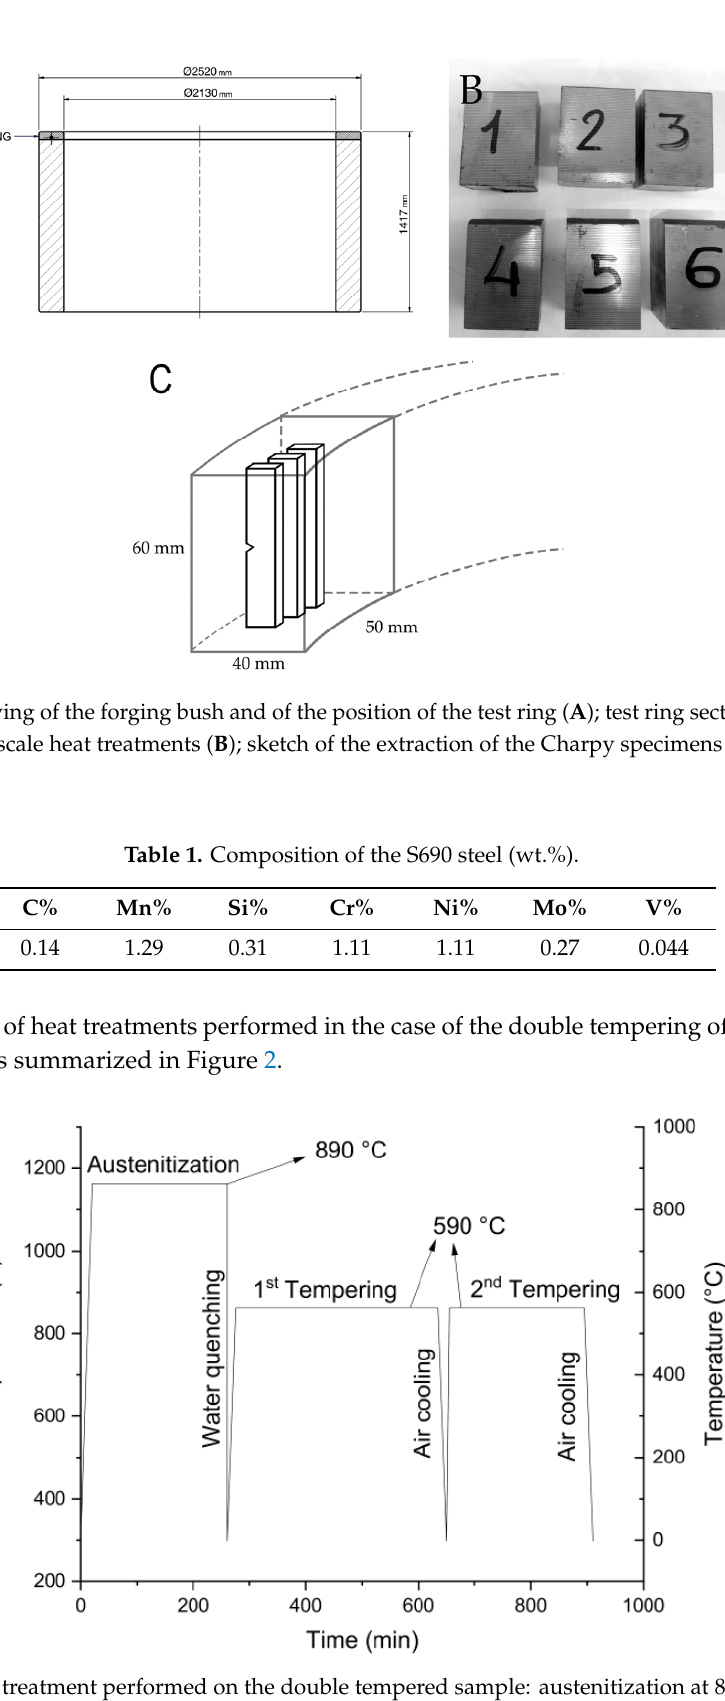
Figure 2. Heat treatment performed on the double tempered sample: austenitization at 890 °C for 4 h, first tempering at 590 °C for 6 h and second tempering at 590 °C for 4 h.